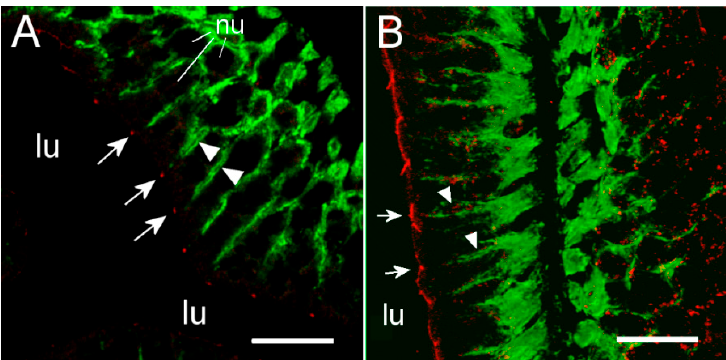
Figure 8. Confocal images showing apical localization of Cldn15a (red in A ) and Cldn15b (red in B ) and basolateral localization of Na + ,K + -ATPase alpha subunit (green) in SW-acclimated medaka middle intestine. lu = lumen; arrows point to Cldn15 “hot spots” in the tight junction zones; arrowheads point to lateral membranes of enterocytes clearly separating the intercellular space. Size bars indicate 10 µ m.